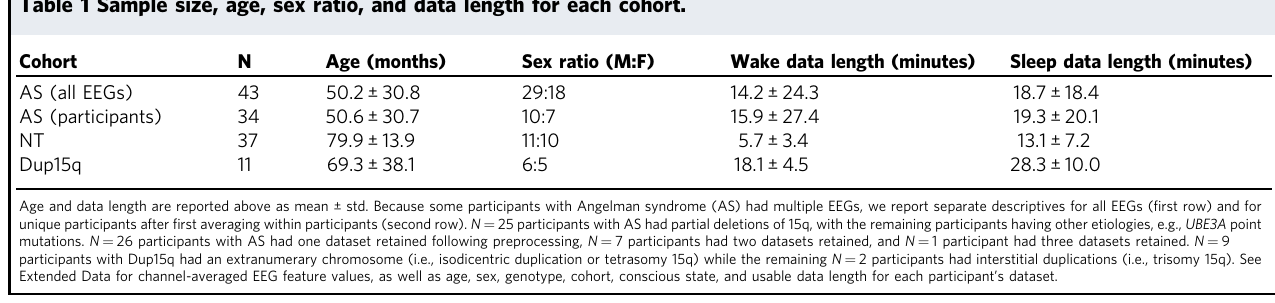
Table 1 Sample size, age, sex ratio, and data length for each cohort.